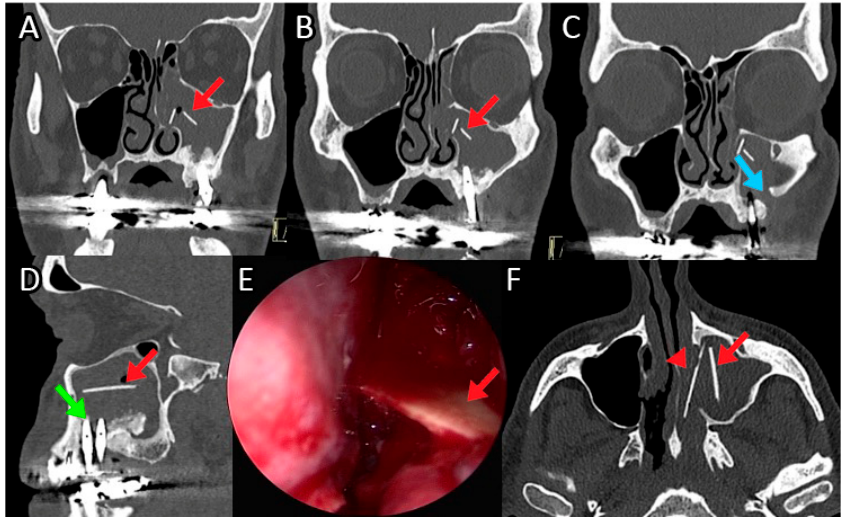
Figure 6. Male patient, 59 years old, complaining of sinus pain, nasal obstruction, and rhinorrhea. CT revealed the presence of a foreign body (2 bars of hydroxyapatite used for the sinus lift preim- plantation in the left maxillary sinusitis), as well as maxillary sinusitis, oroantral fistula, and implant displacement with bony reabsorption. Endoscopic surgery was performed to remove the foreign body ( E ) and to clean the maxillary sinus and OAF closure. Persistence of oroantral fistula was observed and was approached by surgical closure using a local mucosal flap. Red arrow in ( A , B , E ) indicates the foreign body; Light blue arrow in ( C ) indicates OAF; green arrow in ( D ) indicates the implant displacement, and red arrow the foreign body; in ( F ), red arrow and arrowhead indicate the two bars in the axial